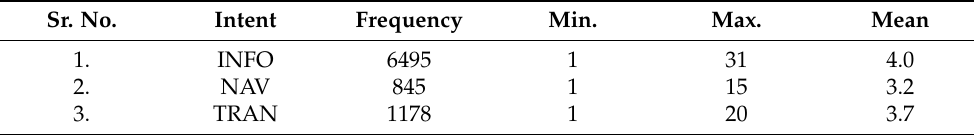
Table 5. Minimum, maximum and mean query length with respect to query intent. Sr. No.